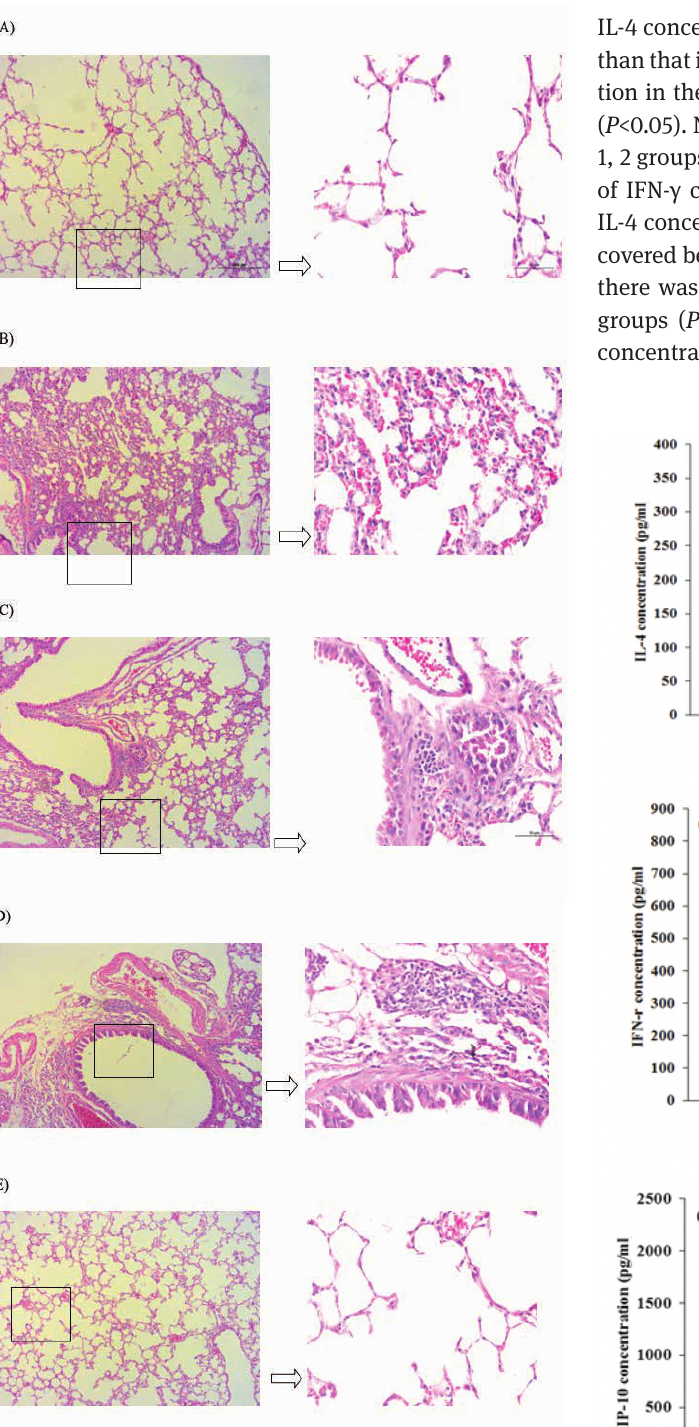
Figure 2: Morphological assessment of emphysema. (A) The lung of the mice only exposed to cigarette smoke; (B) the lung of the mice exposed to normal air (control); (C) the lung of the mice exposed to ; (D) the cigarette smoke and administrated with 1000u of vitamin D 3 Figure 3: The concentrations of IL-4, IFN-γ and CXCL10 in BALF. (A) lung of the mice exposed to cigarette smoke and administrated with The concentration of IL-4 in BALF; (B) The concentration of IFN-γ 2000u of vitamin D ; (E) the lung of the mice exposed to cigarette 3 in BALF; (C) The concentration of CXCL10 in BALF. Different letters smoke and administrated with 3000u of vitamin D . 3 denoted significantly different ( P <